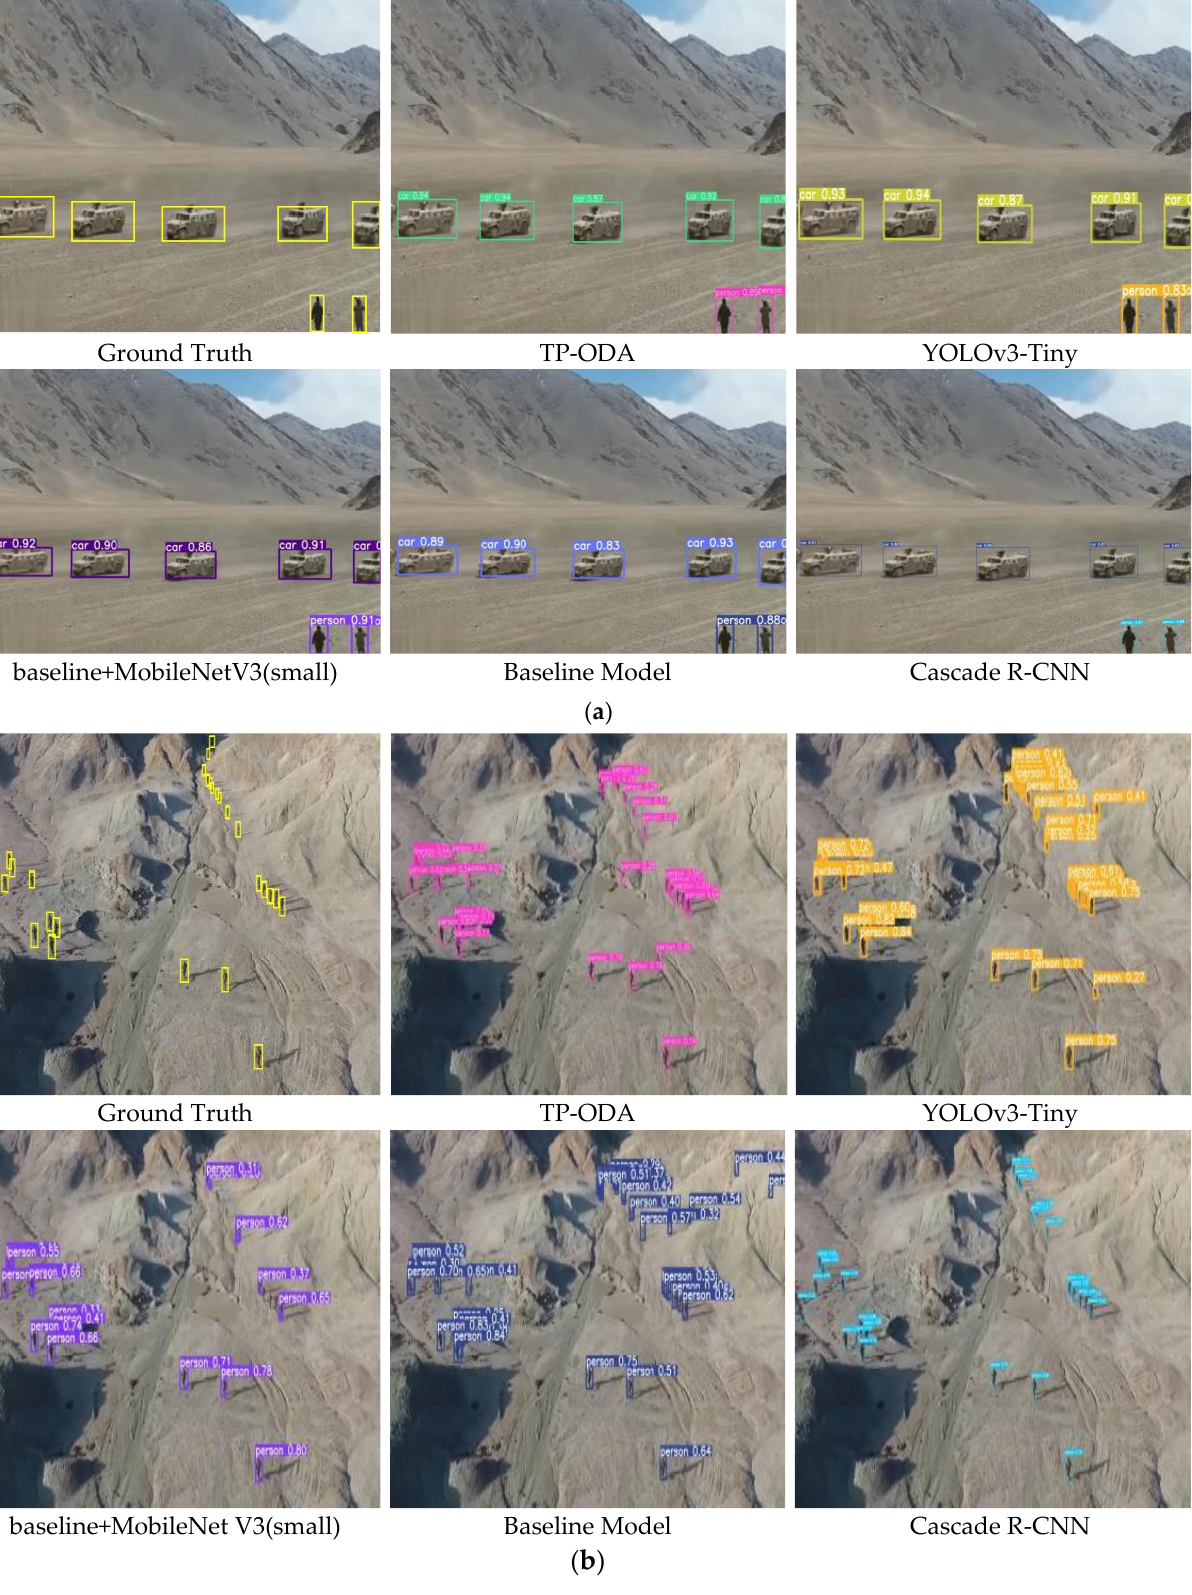
Figure 7. Desert background visualization detection results. ( a ) Low-altitude horizontal view. ( b ) Overhead view.